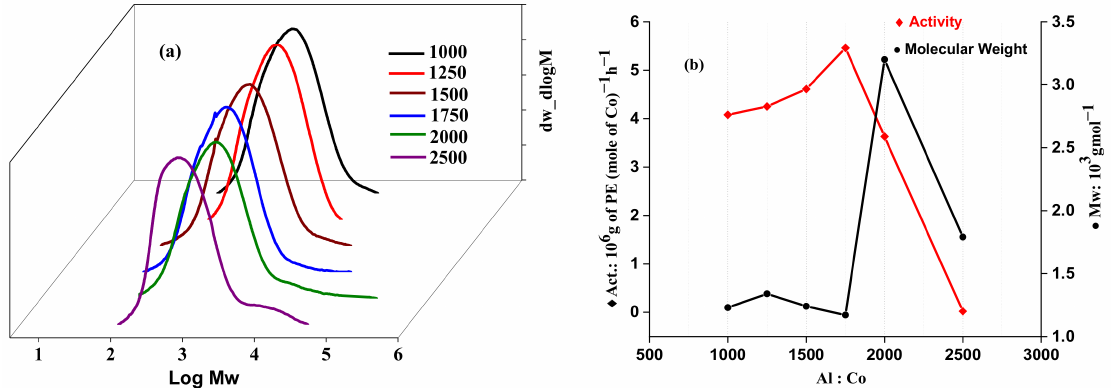
Figure 7. GPC curves of the obtained polyethylene ( a ); activity and M w as a function of Al/Co ratio ( b ) for the Co1 /MMAO system (Table 3, entries 6–10).